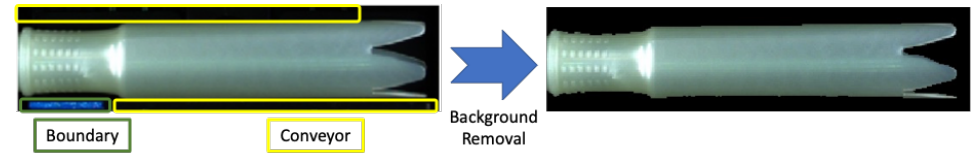
Figure 17. Background removal by contouring. After image slicing, the image was reduced to 80 × 320 pixels, which is small enough to deform the feature, deteriorating the accuracy and sensitivity. Additionally, the applied object-detection model, YOLOv4, requires a square image. To reduce the possible feature deformation and for applying YOLOv4 we resized the image to 320 × 320 pixels with padding. The result of resizing is presented in Figure